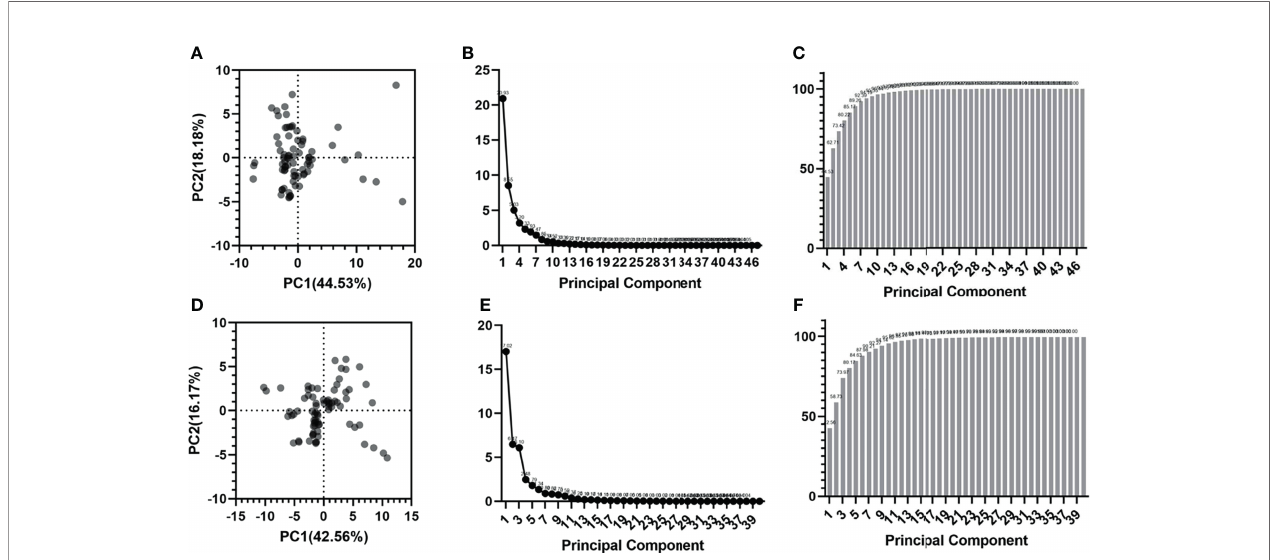
FIGURE 6 | Radiomic features dimensionality reduction using PCA. (A-C) are the score plot, scree plot and proportion of variance plot for tumor tissue-derived radiomic features. (D-F) are the score plot, scree plot and proportion of variance plot for peritumoral tissue-derived radiomic fi rst principal component (PC1) and the second principal component (PC2) are 44.53% and 18.18%, respectively. The eigenvalues for each principal component are shown in Figure 6B . The cumulative proportion of variance is presented in Figure 6C . The fi rst seven principal components can preserve at least 90% (92.39%) of the variance of the original feature set. For peritumoral tissue-derived radiomic features, the variance contribution rates of PC1 and PC2 are 42.56% and 16.17%, respectively. The eigenvalues for each principal component are listed in Figure 6E . The cumulative proportion of variance is shown in Figure 6F . The fi rst seven principal components can preserve at least 90% (90.21%) of the variance of the original feature set.